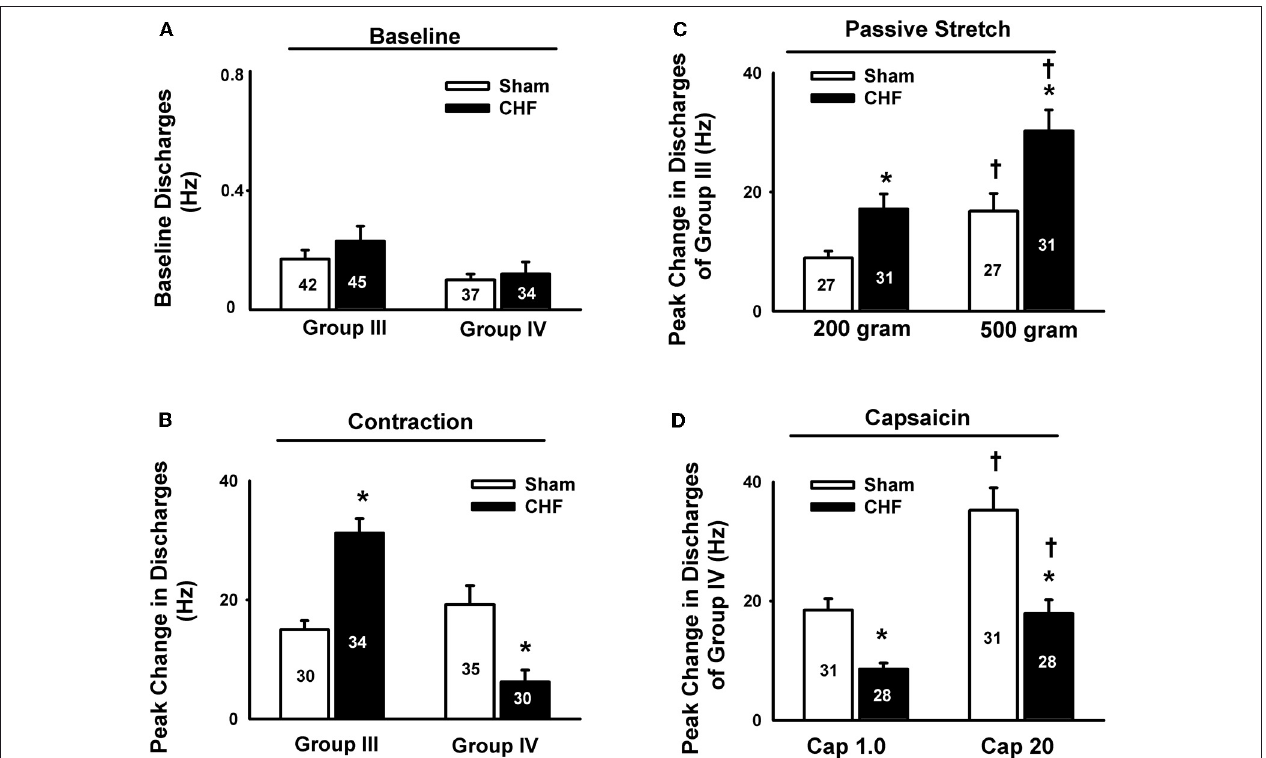
stretch (C) and two doses of capsaicin (D) respectively in sham and CHF rats. Data are expressed as Mean ± SE. ∗ P < 0 . 05 vs. sham, † P < 0 . 05 vs. lower level of stretch or lower dose of capsaicin. [Reprinted from Wang et al. (2010a). Copyright @ 2010 The Physiological Society. Used with